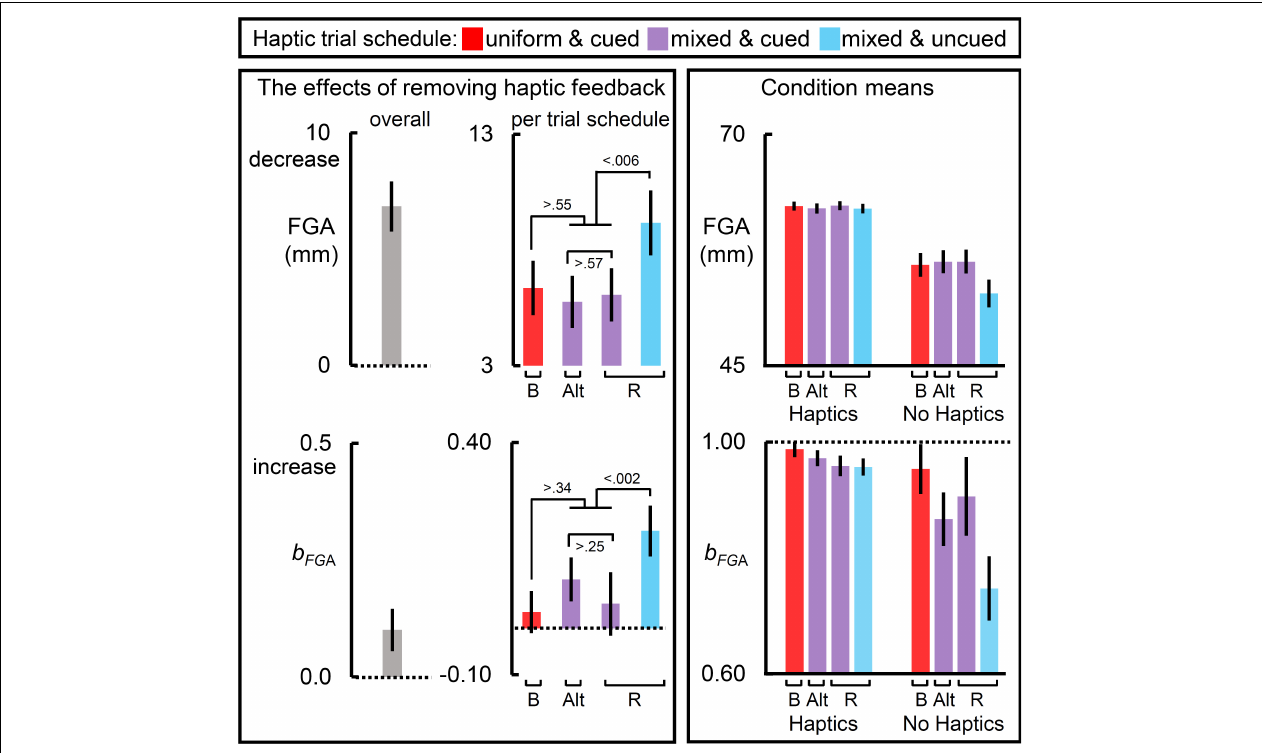
FIGURE 4 | The effects of removing haptic feedback on the “final” grip component measures. The leftmost and middle columns of panels reflect the effects of removing haptic feedback on the final grip aperture (FGA) and the slope relating target size to FGA ( b FGA ). Removing haptic feedback decreased FGA and increased b FGA (leftmost panels). Most notably, the schedule of haptic feedback modulated these effects (middle column of panels). On each measure, the blocked scheduled yielded the largest effect, the cued mixed schedules yielded an intermediate one, and the randomly interleaved schedule yielded the weakest effect. The raw condition means for each measure are depicted in the rightmost panels. Bar label “B” refers to the blocked trial order; “Alt.” alternating block of trials; and “R” randomized ones. Dotted lines reflect a null effect of removing haptic feedback. All error bars reflect SEMs, and the dotted lines reflect the null hypothesis for tests against zero (left panels and middle bottom panel) or one (bottom right